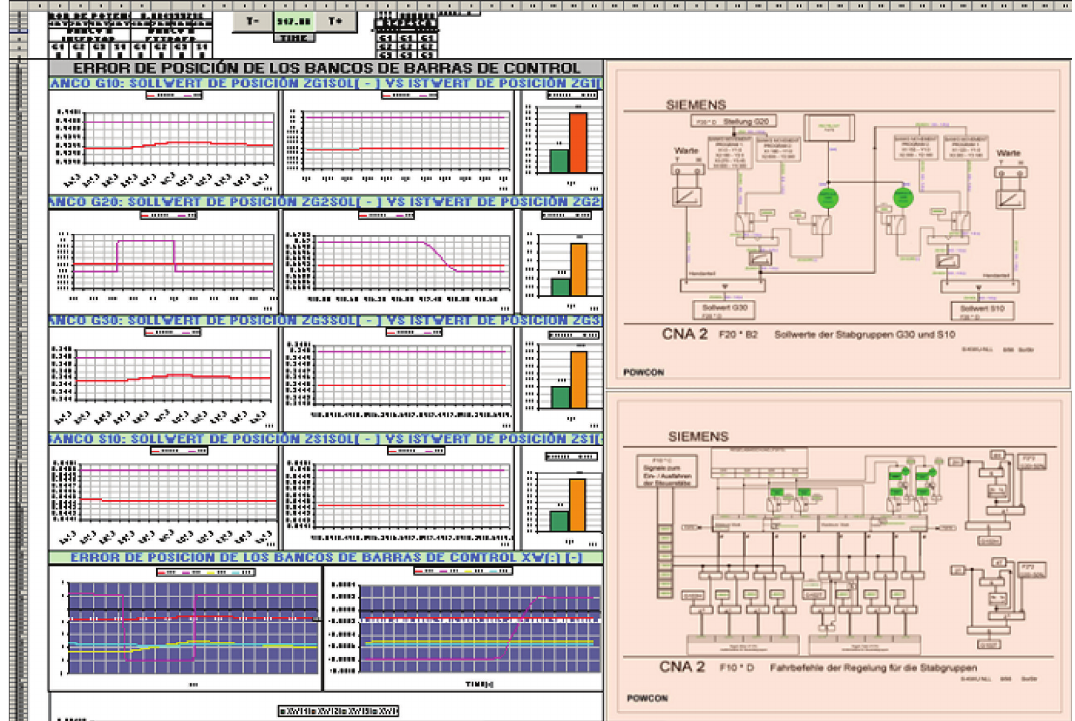
Figure 13: Postprocessing spreadsheet. Control rod banks set points and errors with the associated functional diagrams to aid in the back- tracking of the decisions taken by the reactor power control system.